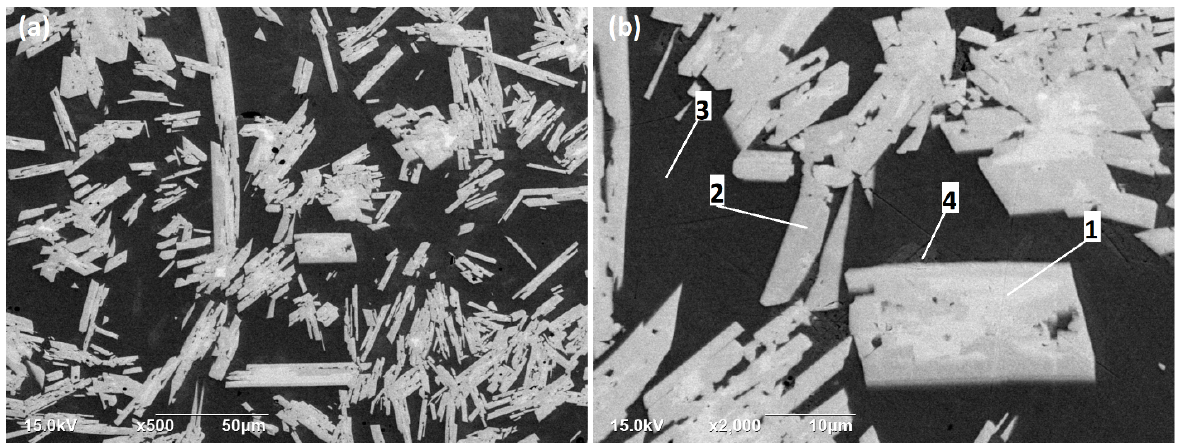
Figure 6: SEM/BSE images of the as-cast alloy sample E with the magnifications of a) × 500 and, b) × 2000